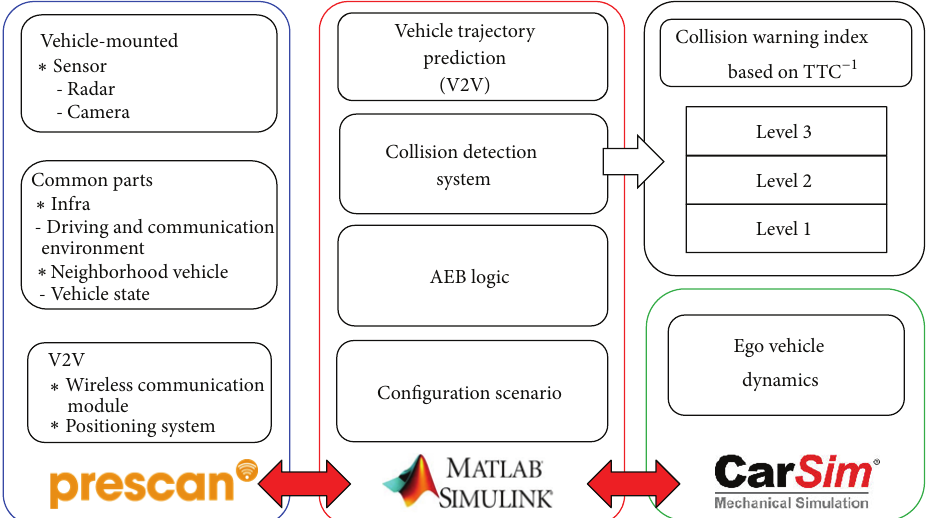
Figure 1: Block diagram of analysis model.